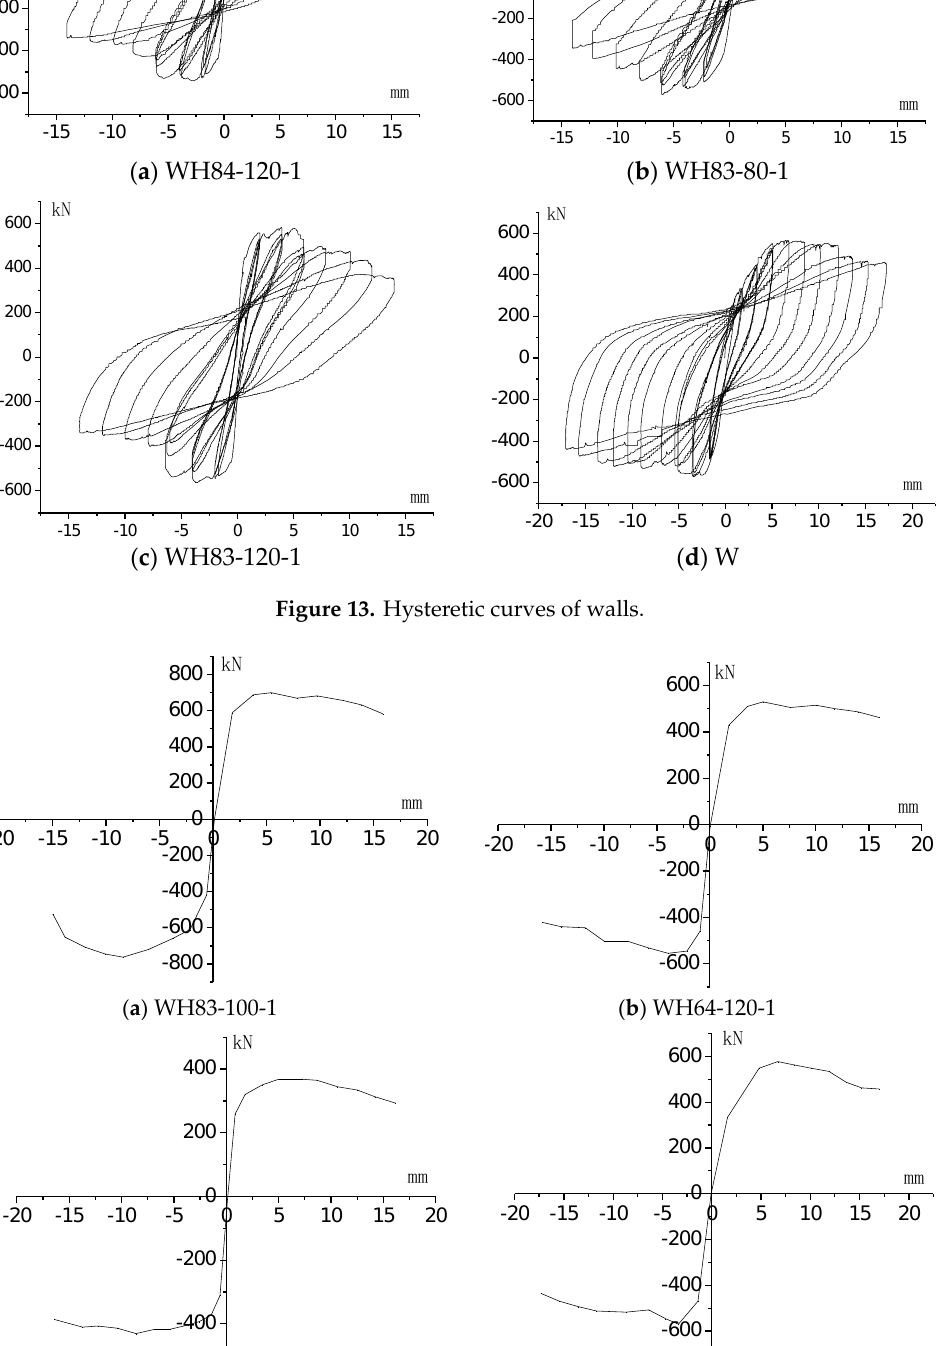
Figure 14. Envelope curves of walls. Do not divide Figure 14 in 2 pages